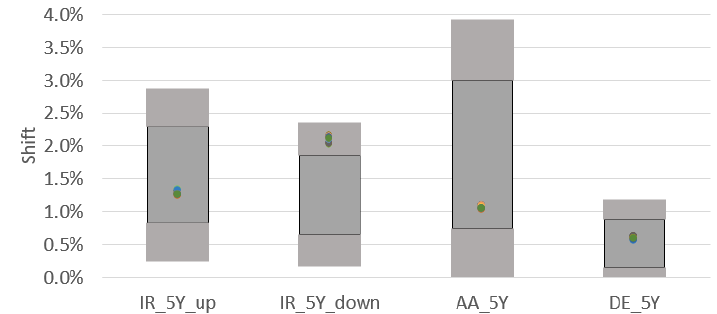
Figure 15. Comparison of the GAN risk charges in 20 different runs versus MCRCS study for four risk